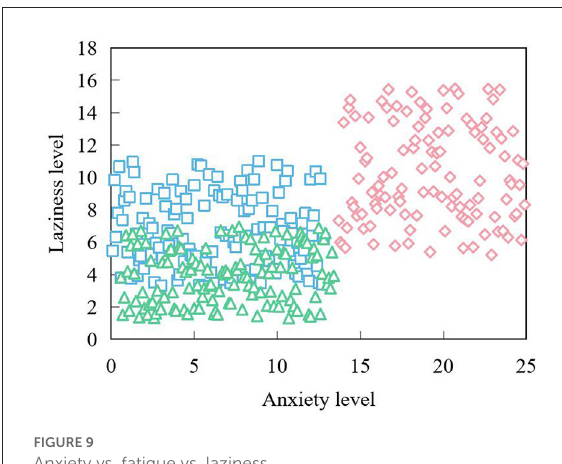
FIGURE9 Anxiety vs. fatigue vs.